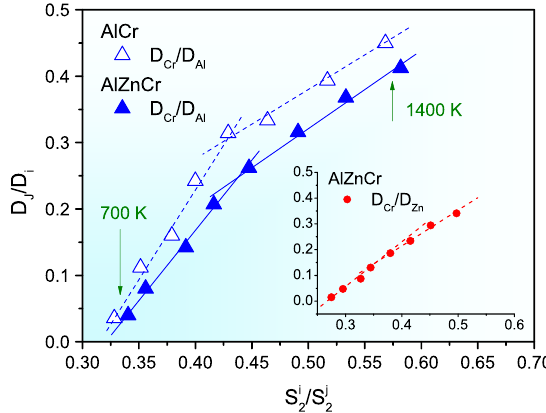
Fig. 7 Ratio of the self-diffusion coef fi cients D i / D j as function of = S i S j for Al − Cr binary alloy, as well as the Al − Zn − Cr ternary alloy, as 2 2 well as for the